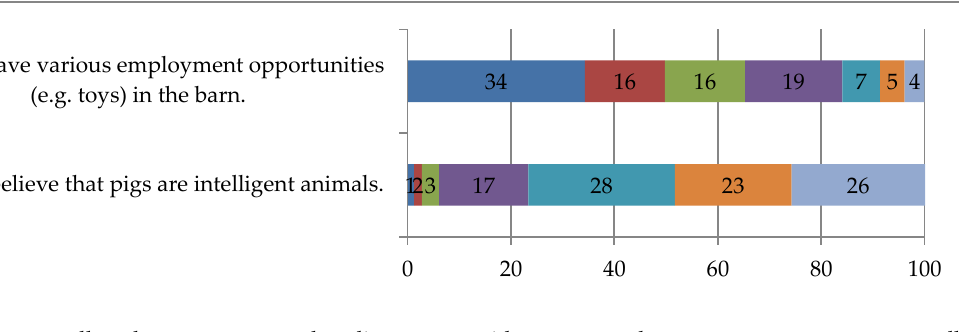
Figure 3. Frequency distribution of the statements regarding the pig farm. Agriculture 2020 , 10 , x FOR PEER REVIEW